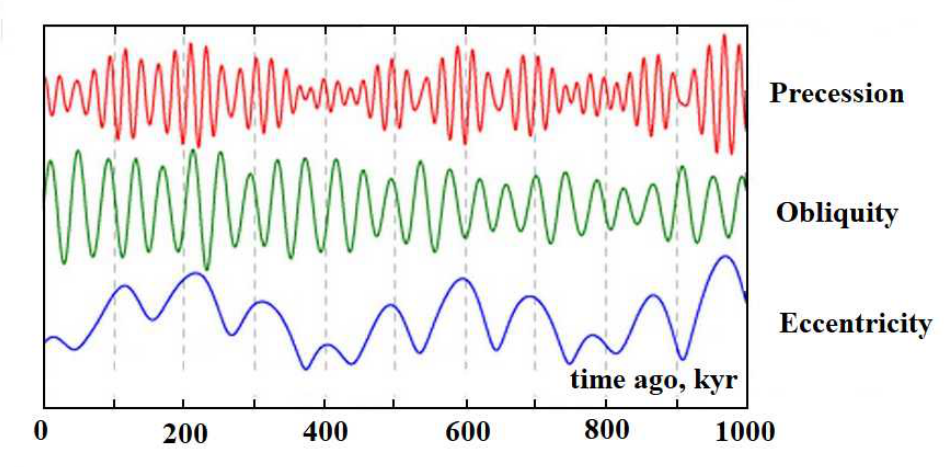
Figure 5. Evolution of the solar radiation flux in the visible range of spectrum as a result of oscillations of the Earth’s orbit relative to the Sun. The time dependence for the flux of solar radiation entering the Earth’s atmosphere is presented in the case of each of oscillation types for the Earth’s orbit relative to the Sun within the framework of the Milankovich model